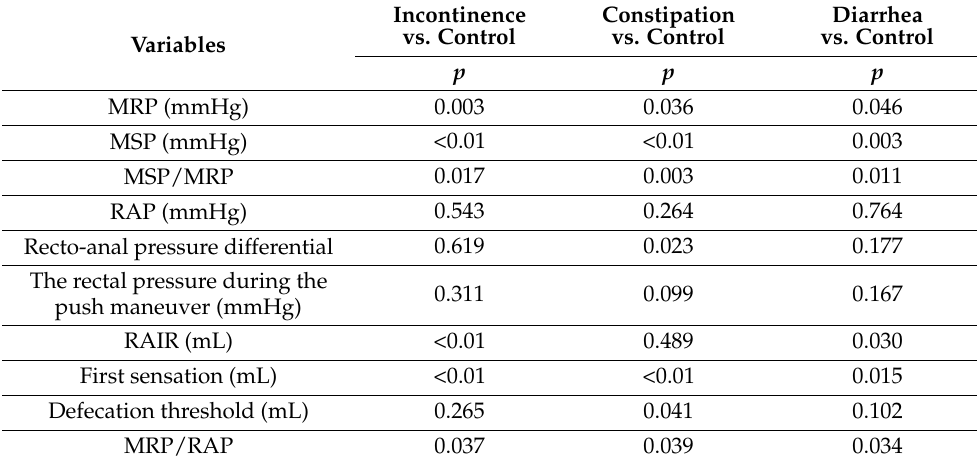
Diarrhea vs. Control